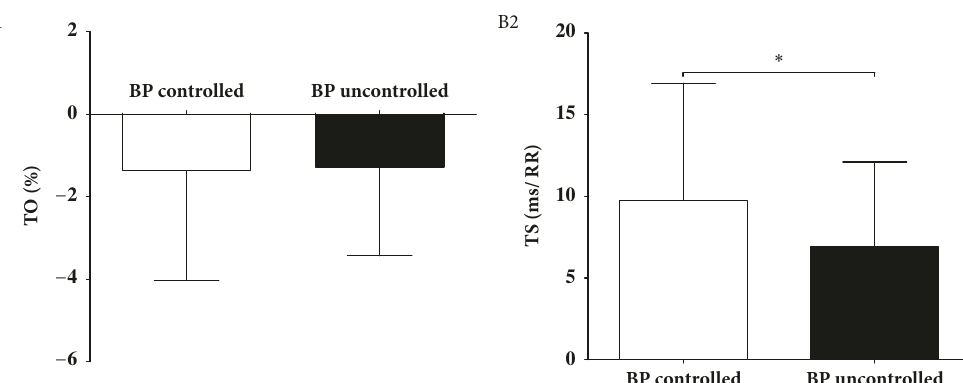
Figure 2: HRV and HRT analysis of BP controlled and BP uncontrolled groups, ∗ P < 0.05; ∗∗ P < 0.01. HRV, heart rate variability; HRT, heart rate turbulence; BP, blood pressure; SDNN, standard deviation of NN intervals; SDANN, standard deviation of all 5-minute average NN intervals; rMSSD, square root of mean of the sum of squares of successive NN interval differences; pNN50, number of successive NN intervals differing by > 50ms divided by the total number of successive NN intervals; VLF, very low frequency; LF, low frequency; HF, high frequency; TO, turbulence onset; TS, turbulence slope.